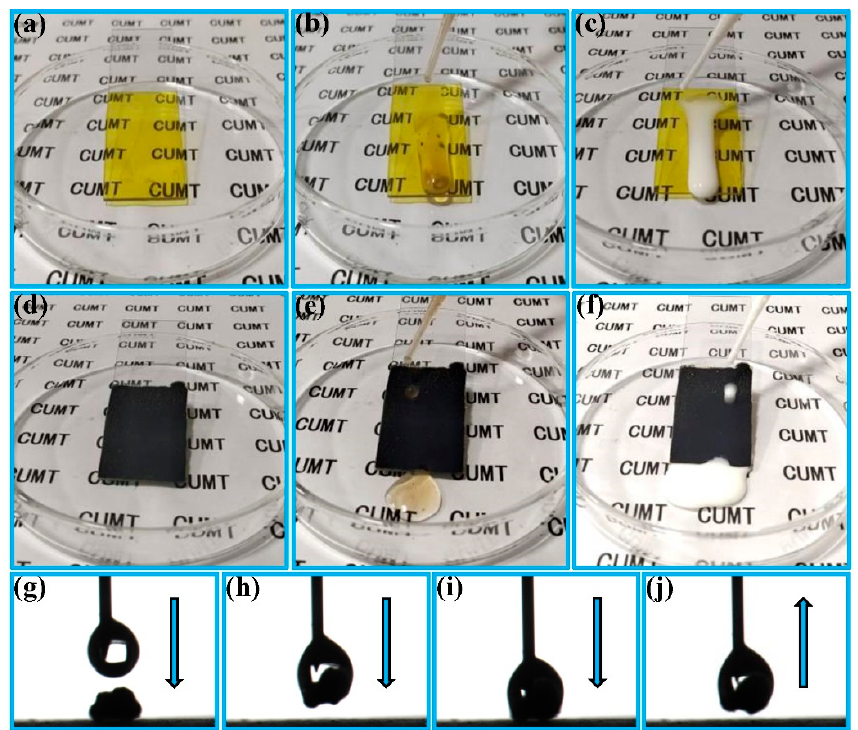
Figure 7. ( a ) Image of the PI surface. Anti-fouling properties of the PI surface demonstrated with different contaminated fluids (corrosive polishing waste liquid ( b ) and milk ( c )); ( d ) image of the FCS coating. Anti-fouling properties of the FCS coating demonstrated with different contaminated fluids (corrosive polishing waste liquid ( e ) and milk ( f )). Principle verification of the self-cleaning and anti-pollution properties of the FCS coating surface ( g – j ).